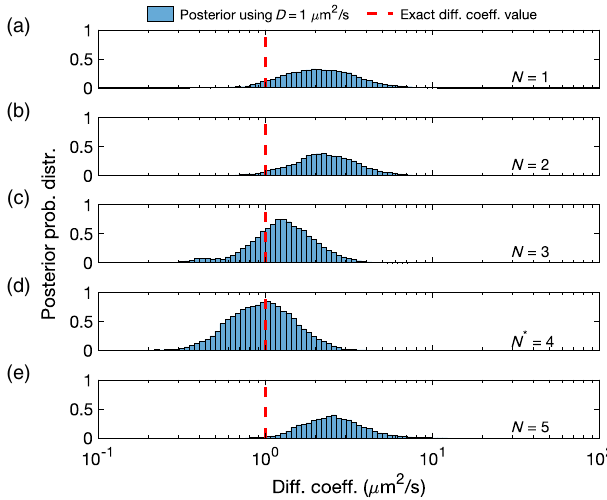
FIG. 2. Estimates of diffusion coefficients from photon arrival traces strongly depend on the number of molecules assumed to be contributing to the trace. The trace analyzed contained ≈ 1800 photon arrivals produced by four molecules diffusing at 1 μ m 2 = s for a total time of 30 ms under background and molecule photon emission rates of 10 3 photons = s and 4 × 10 4 photons = s, respectively. To estimate D parametrically, we assume a fixed number of molecules, N ¼ 1 (a); N ¼ 2 (b); N ¼ 3 (c); N ¼ 4 (d); and N ¼ 5 (e). The correct estimate in (d) — and the mismatch in all others — underscores why it is critical to estimate the number of molecules contributing to the trace to deduce quantities such as diffusion coefficients from single-photon